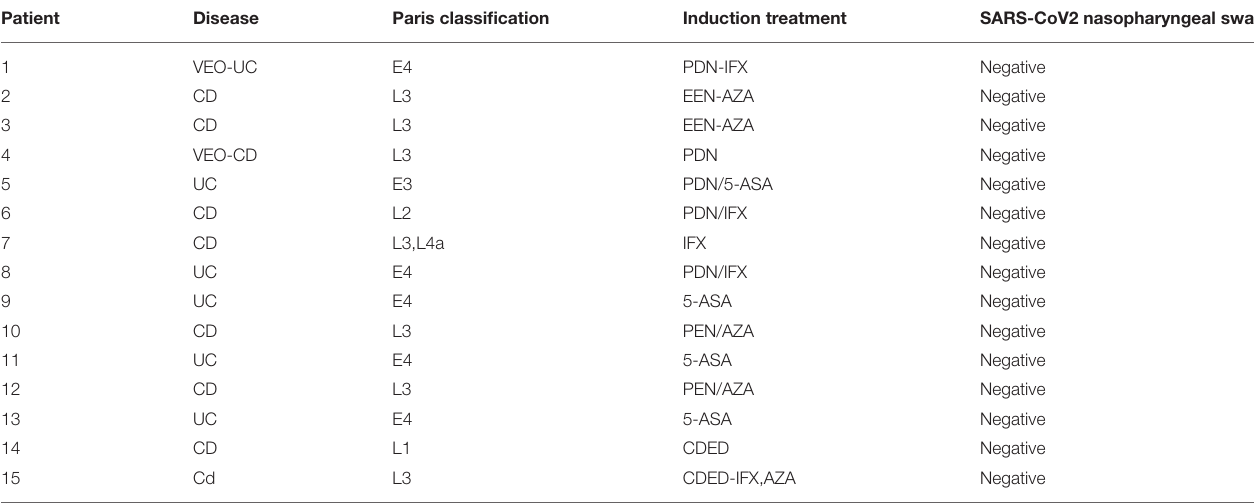
TABLE 3A | Clinical features of new PIBD patients and SARS-CoV2 diagnostic testing. Patient